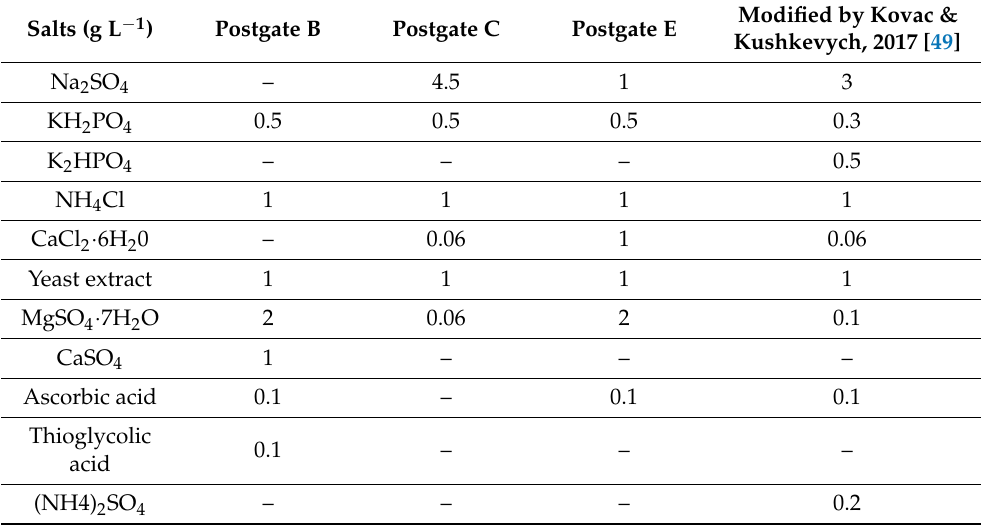
Table 1. Composition of different cultivation